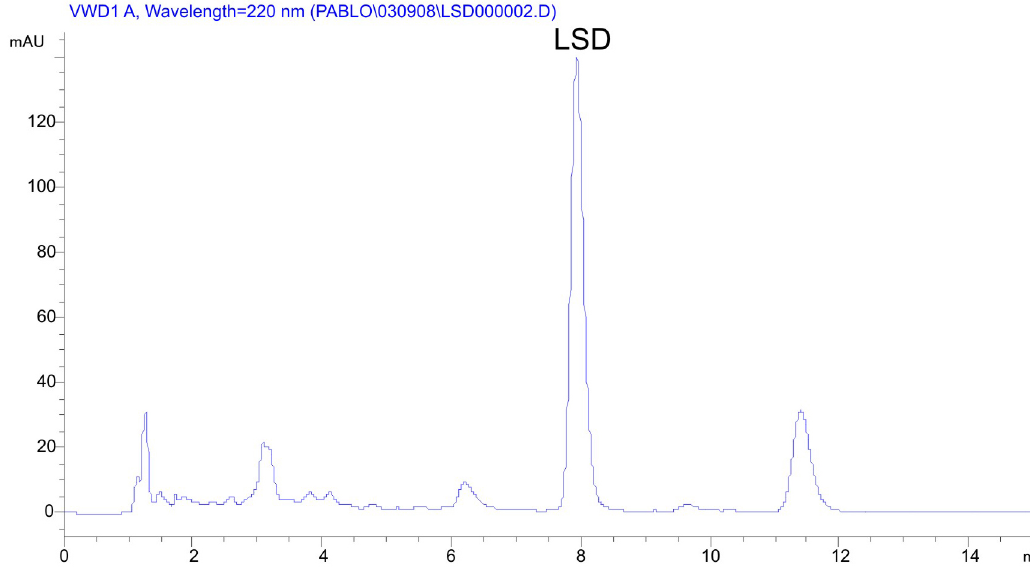
FIGURE 9 - Chromatogram after injection of blotter extract in methanol: water (1:1) tr LSD = 7.86 TABLE IV - LSD in 22 blotters seized by Police of Minas Gerais state